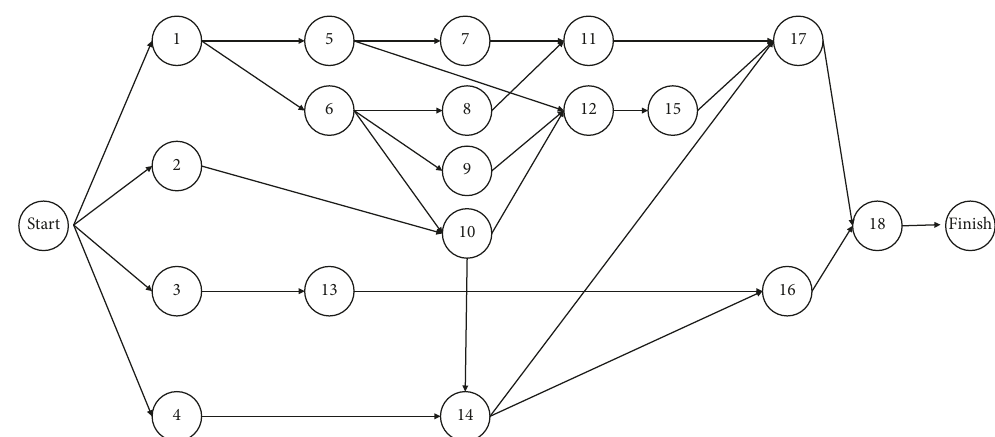
Figure 6: Project network activities in the case